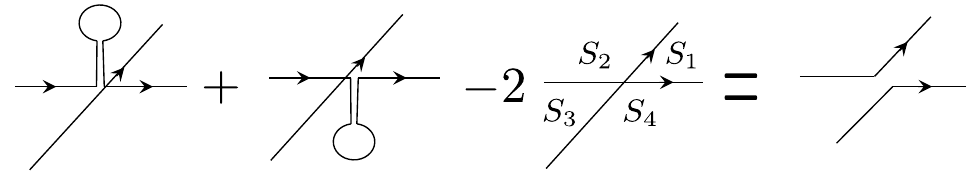
Figure 8 . The area derivatives and the loop laplacian ^ L x . The left hand side is the de(cid:12)nition of ^ L x which can be easily translated into area derivatives. (Adapted from